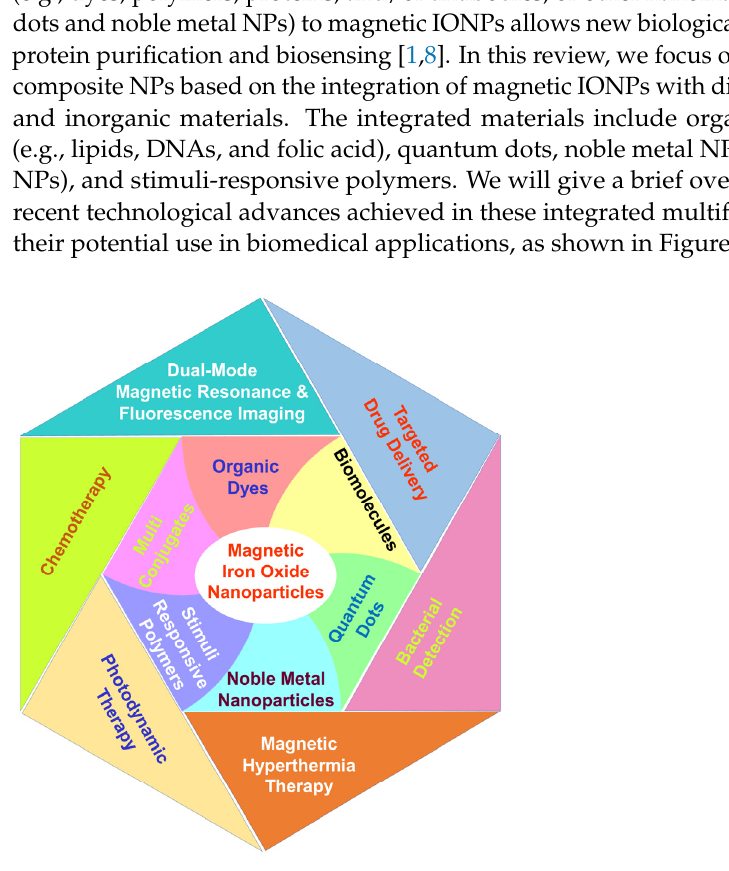
Figure 1. Multifunctional iron oxide NPs integrated with different classes of organic and inorganic materials for biomedical applications.